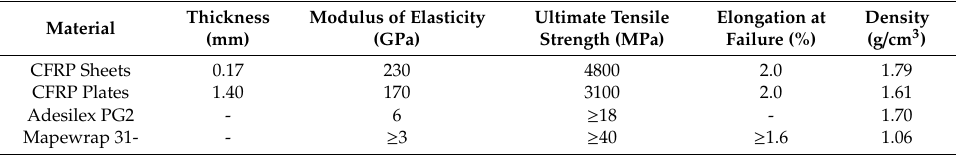
Table 2. Mechanical properties of CFRP sheets, plates and epoxy.